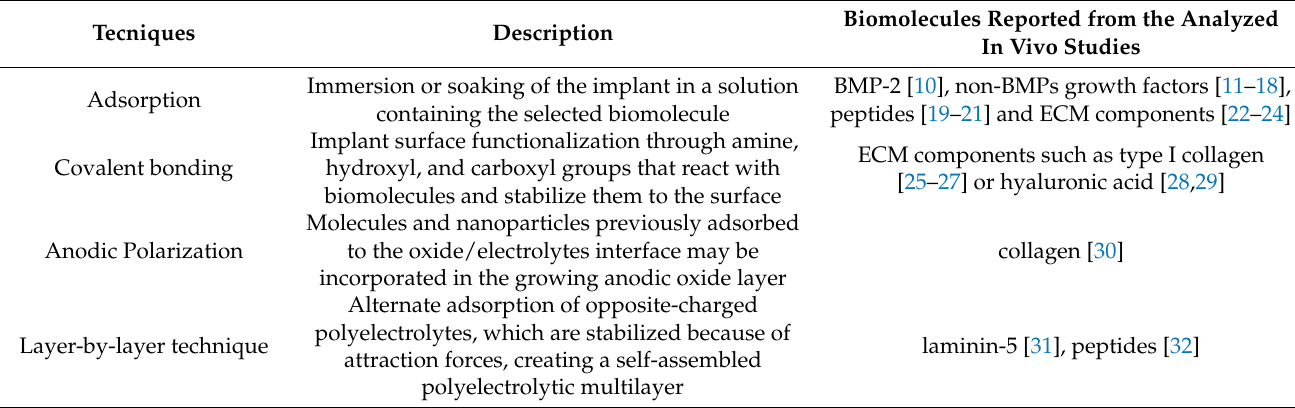
Table 1. Techniques to immobilize biomolecules on titanium implant